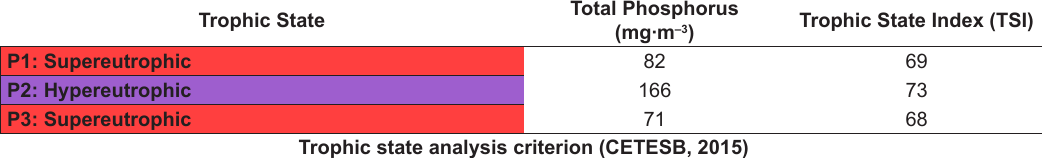
Table 3. Results of Lamparelli’s trophic state analysis (CETESB, 2015) based on the total phosphorus concentration and the trophic state index (TSI) (average among samples by